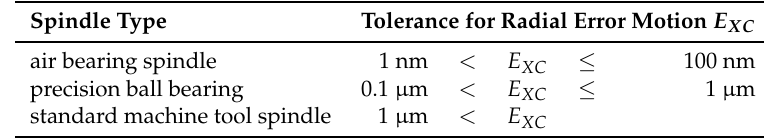
Table 1. Typical radial error motion tolerances for tool spindles depending on bearing type